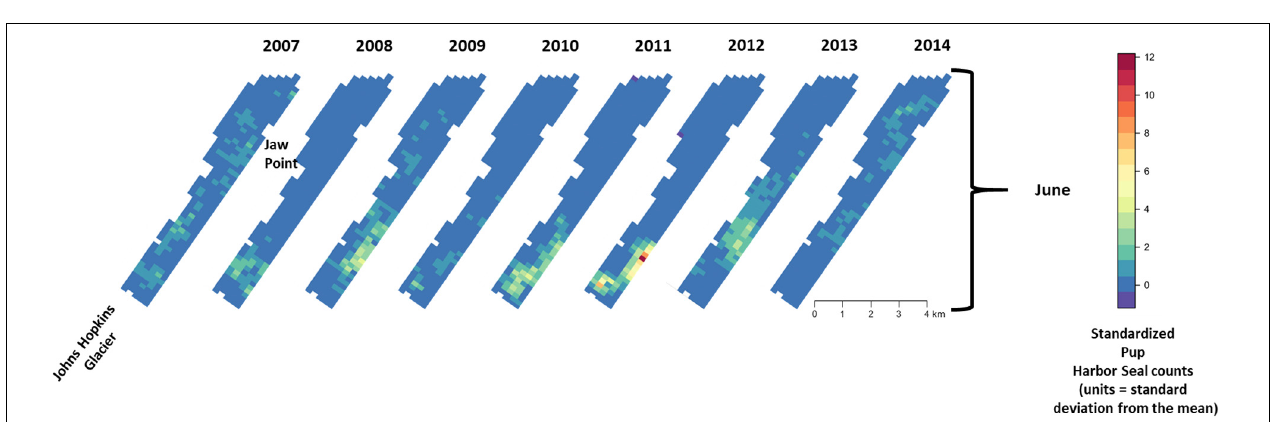
FIGURE 7 | Median of posterior distribution of expected value of z-standardized harbor seal non-pup counts in Johns Hopkins Inlet in Glacier Bay National Park in southeastern Alaska during the pupping period in June (top panel) and during the molting period in August (lower panel) from 2007 to 2014. Grid cell size is 200 m × 300 m.